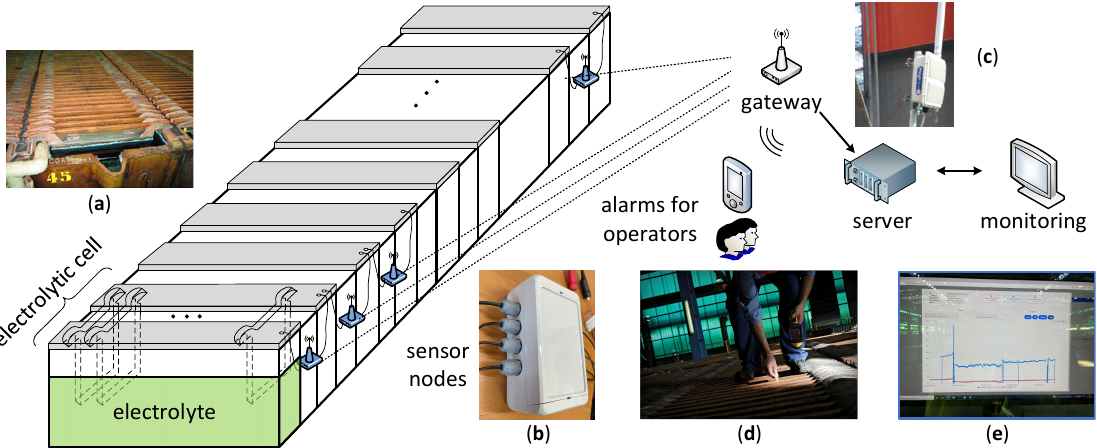
Figure 1. Proposed general system structure. ( a ) Image of the anodes and cathodes of an electrolytic cell. ( b ) Sensor–actuator node. ( c ) Gateway. ( d ) Operator removing a short circuit. ( e ) Monitoring of cell parameters trend with associated process